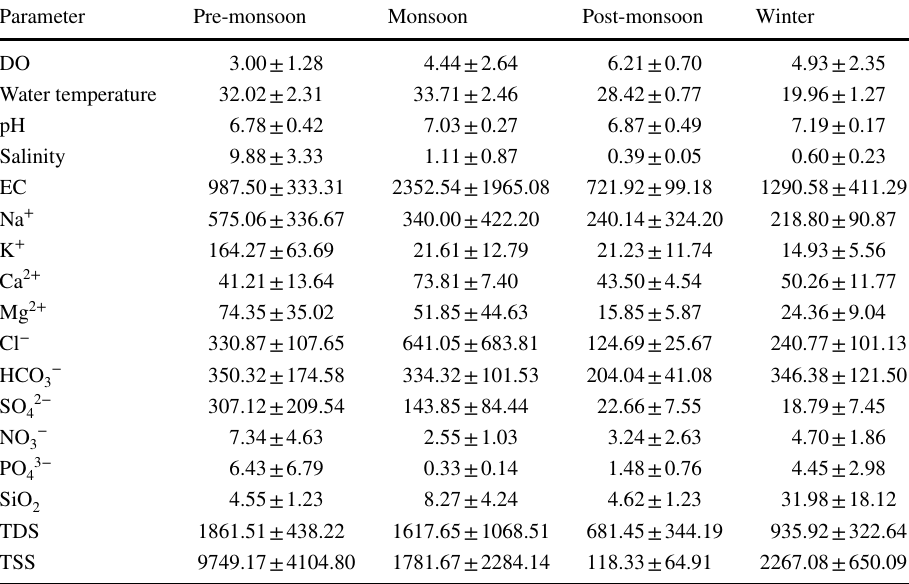
Table 1 Summary hydrochemical composition of the Mayur River